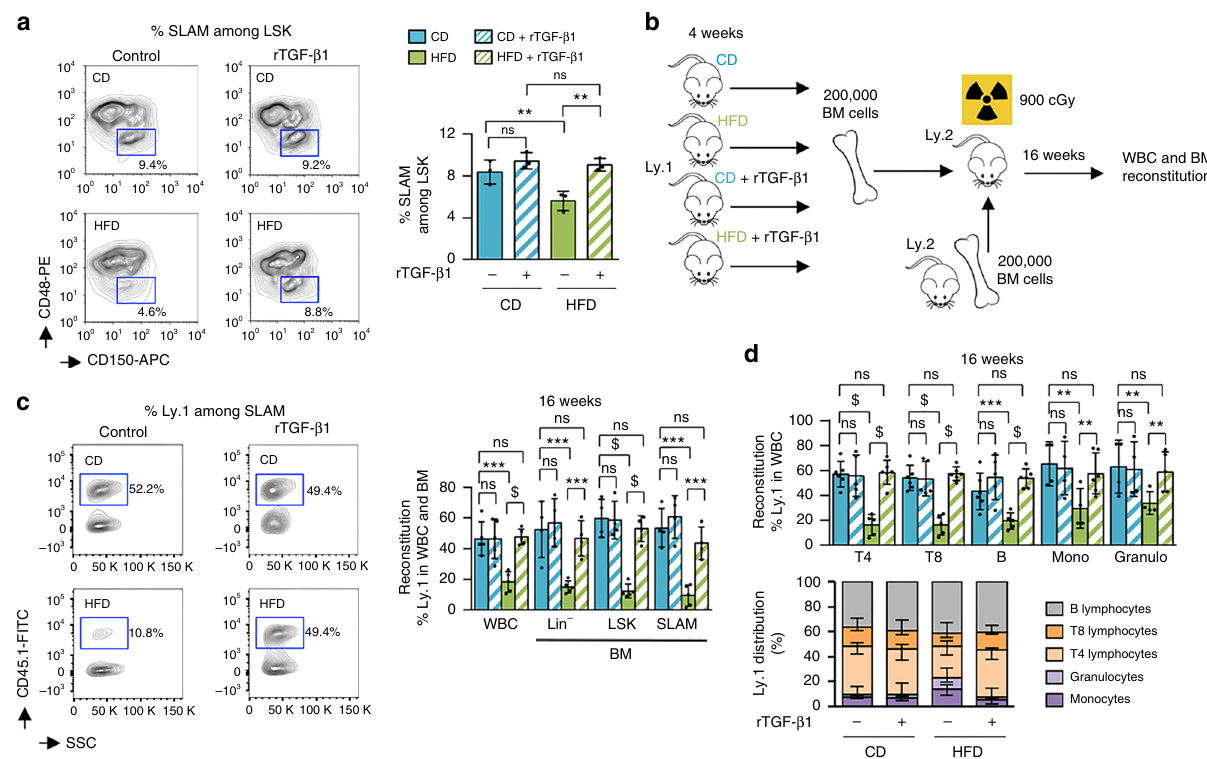
Fig. 7 Injection of recombinant TGF- β 1 in mice compensates for the loss of HSC following a HFD. a Recombinant TGF- β 1 (rTGF- β 1) is injected at 1.3 µ g/kg twice per week into the tail vein of mice during the 4 weeks of the CD or HFD, and erosion of HSC is compensated, n = 3 mice per experimental group. b Experimental work fl ow to show that rTGF- β 1 injection also compensates for HSC function in transplantation assays. c Injection of rTGF- β 1 in HFD-fed mice improves BM ’ s ability to reconstitute, 16-weeks after transplantation in lethally irradiated recipients (mice per experimental group: n = 5 (CD, CD + rTGF- β 1, HFD, HFD + rTGF- β 1) for WBC; n = 4 (CD, CD + rTGF- β 1, HFD + rTGF- β 1) and n = 5 (HFD) for Lin − , LSK, and SLAM. d Reconstitution is further improved in BM (mice per experimental group: n = 6 (CD, HFD + rTGF- β 1) and n = 5 (CD + rTGF- β 1, HFD) for T4, T8, and B; n = 4 (CD, CD + rTGF- β 1, HFD) and n = 6 (HFD + rTGF- β 1) for monocytes (Mono); n = 4 (CD, CD + rTGF- β 1, HFD) and n = 5 (HFD + rTGF- β 1) for granulocytes (Granulo). Data show mean ± SD; ns, non-signi fi cant ( P > 0.05); * P < 0.05; ** P < 0.01; *** P < 0.001; $, P < 0.0001 (two-tailed unpaired Student ’ s t -test)